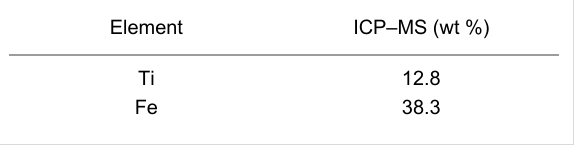
Table 3: Elemental composition of the TiO 2 -Fe 2 O 3 -PS4 nanohybrid material.